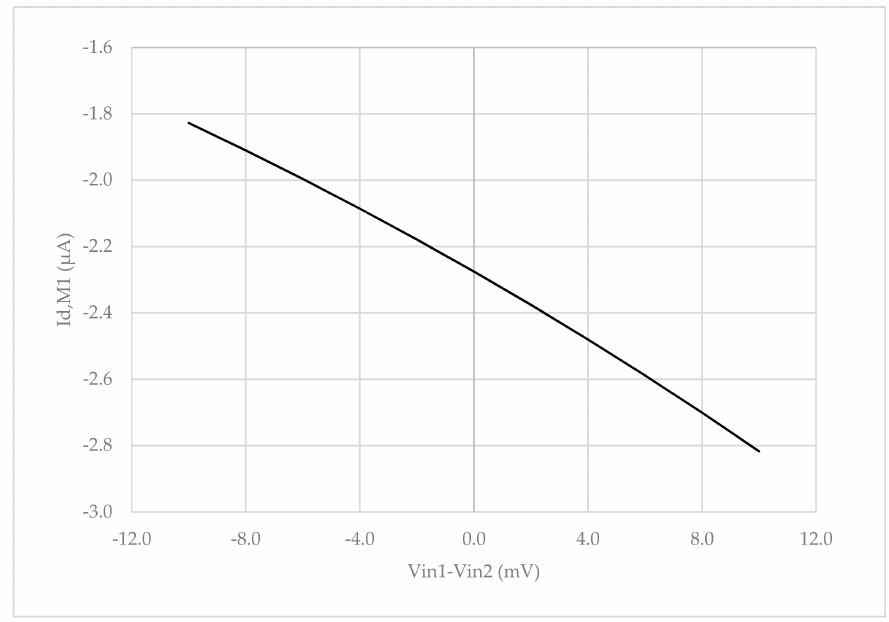
Figure 7. DFVF di ff erential input voltage vs. output current